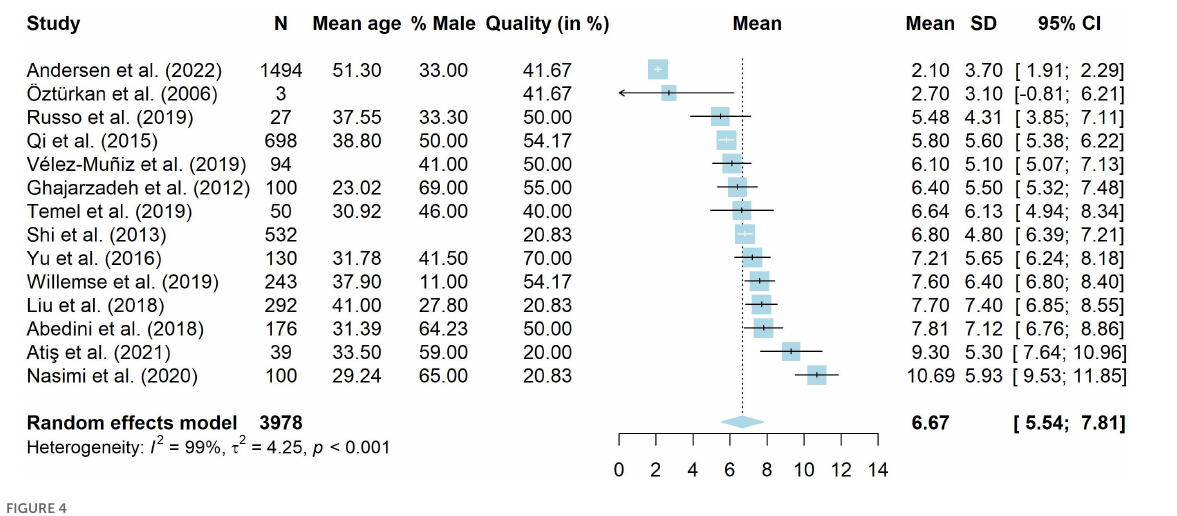
FIGURE4 Forest plot for mean DLQI scores in adults with alopecia